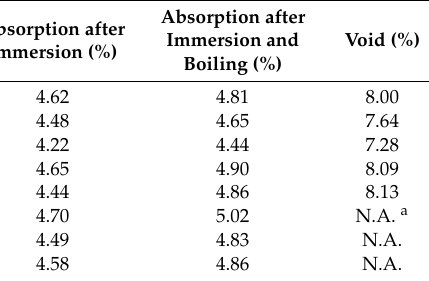
Table 6. Density, void and absorption of concretes at 28 days.